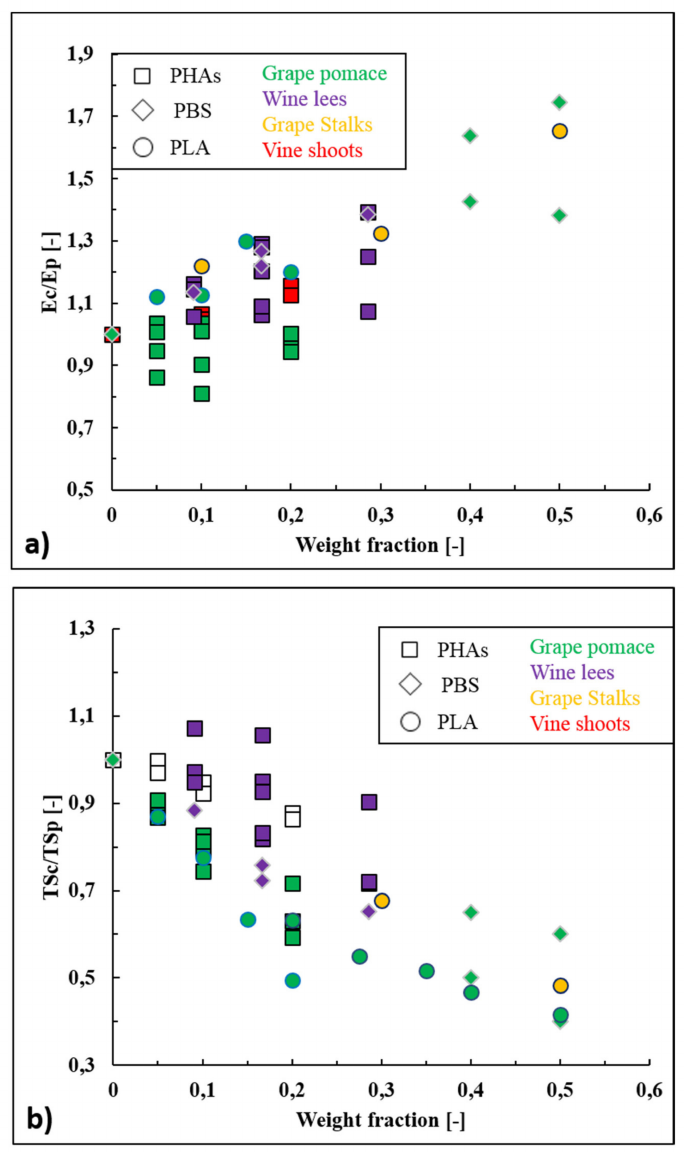
Figure 5. ( a ) Ratios ( E C / E P ) between Young’s modulus of wine-based composites ( E C ) and neat biopolymers ( E P ), and ( b ) ratios (TS C /TS P ) between tensile strength of wine-based composites (TS C ) and neat biopolymer (TS P ) as function of the wine filler